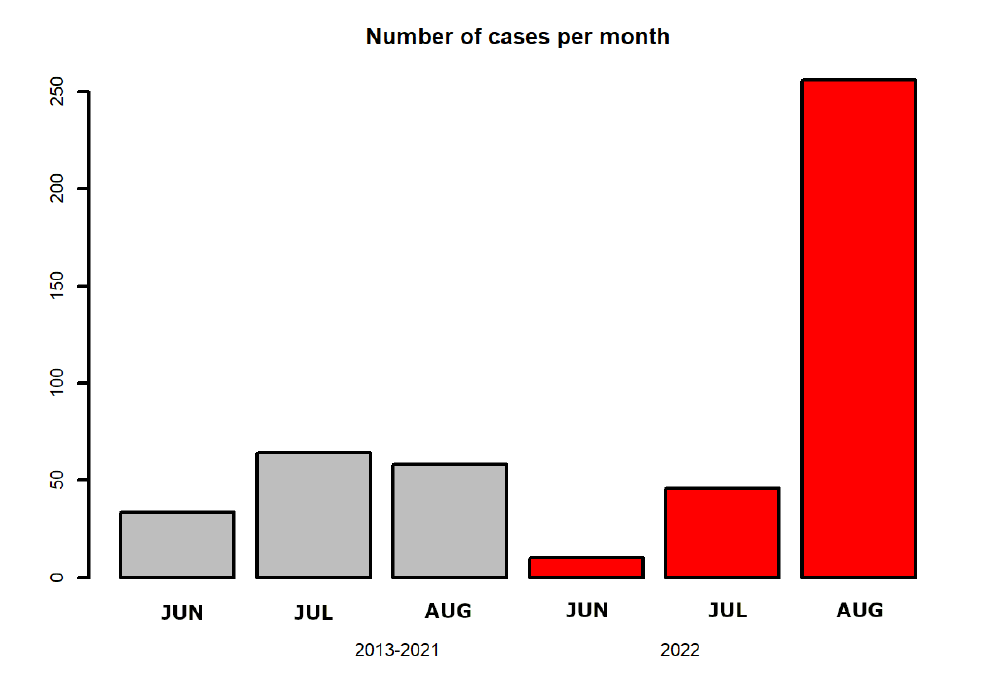
Figure 10. Number of cases per month for the two periods (in grey, averaged for 2013–2021, and in red, for 2022) for the hail swaths estimated with the 20 kg/m 2 VIL